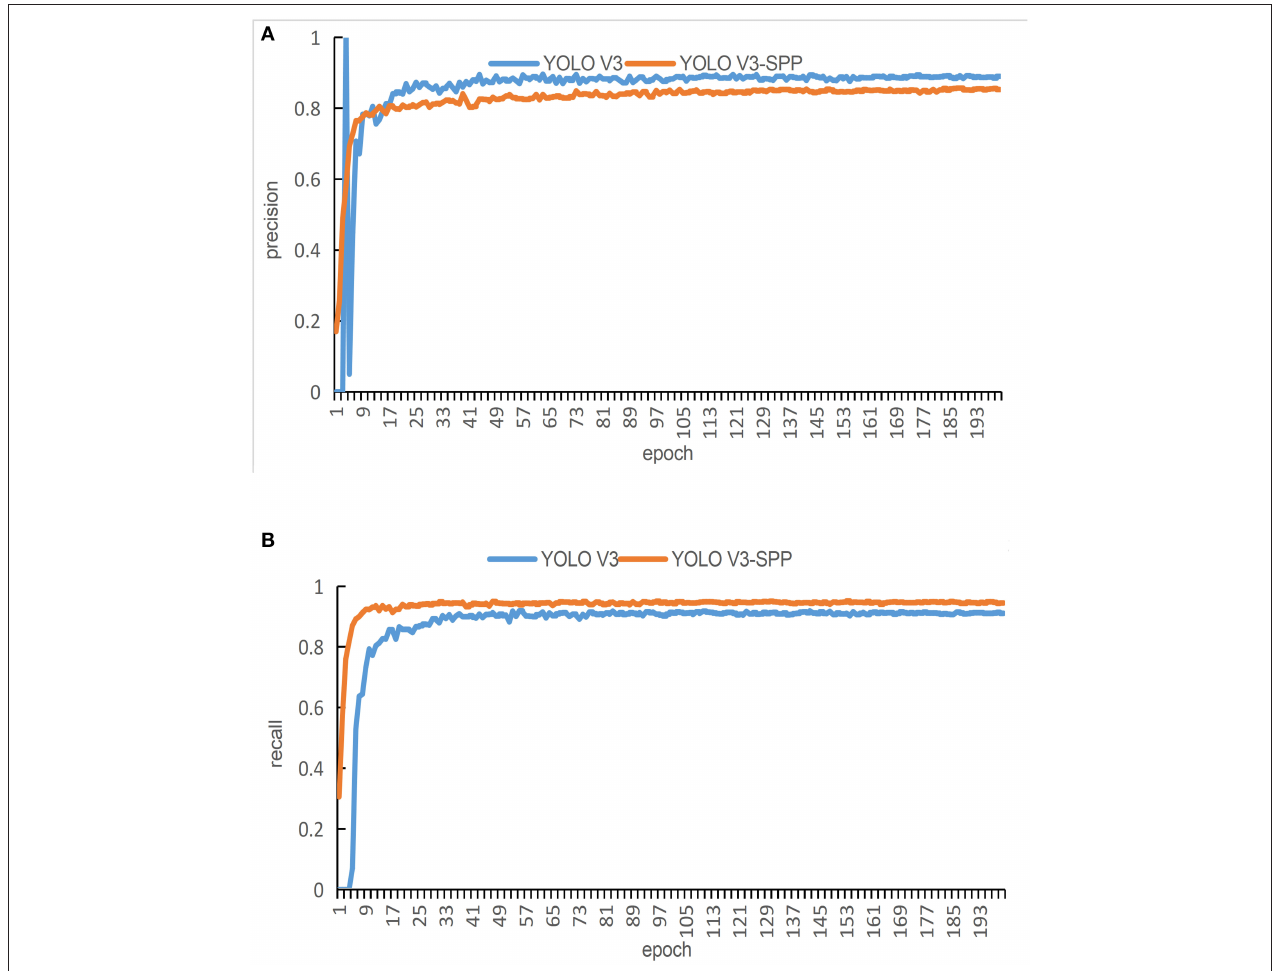
FIGURE 7 | The training results of the detection algorithm by using the original images. (A) A comparison of the original and improved YOLOv3 in terms of precision for detection. (B) A comparison of the original and improved YOLOv3 in terms of recall for